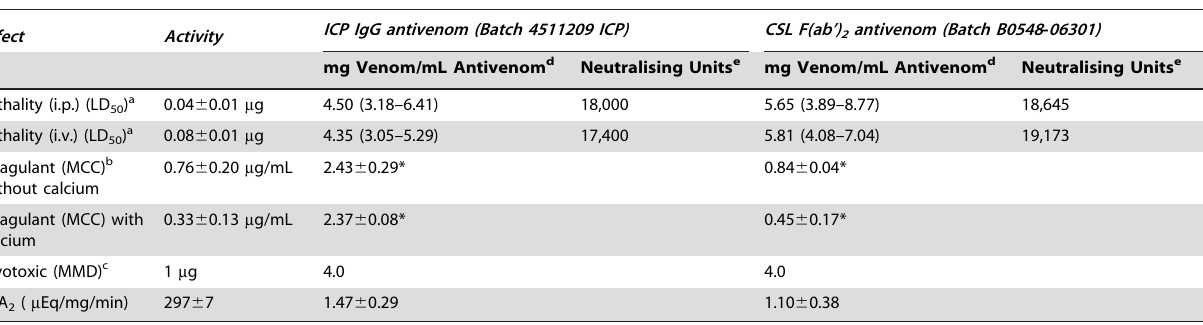
Table 2. Toxic activities of O. scutellatus venom and neutralisation by